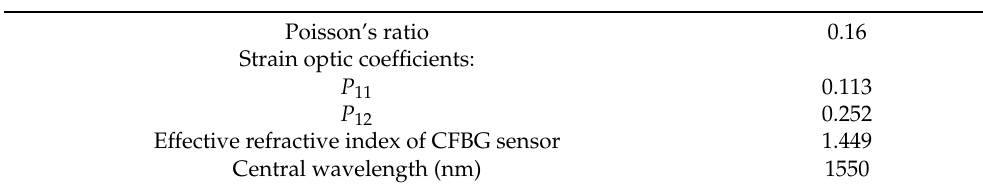
Table 4. SMF-28 ® optical